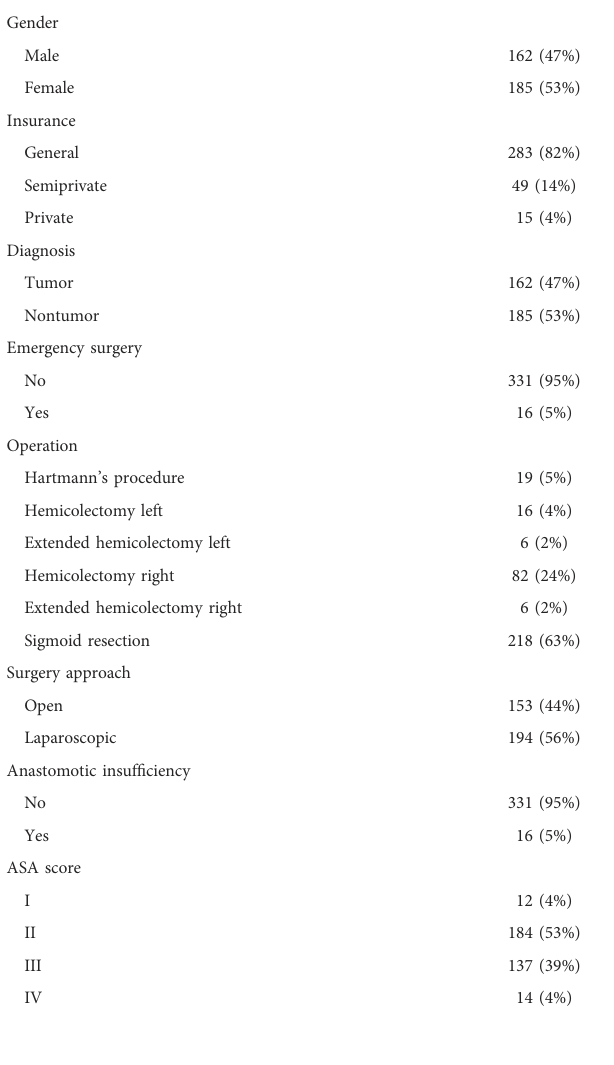
TABLE 2 Variable characteristics for categorical values.